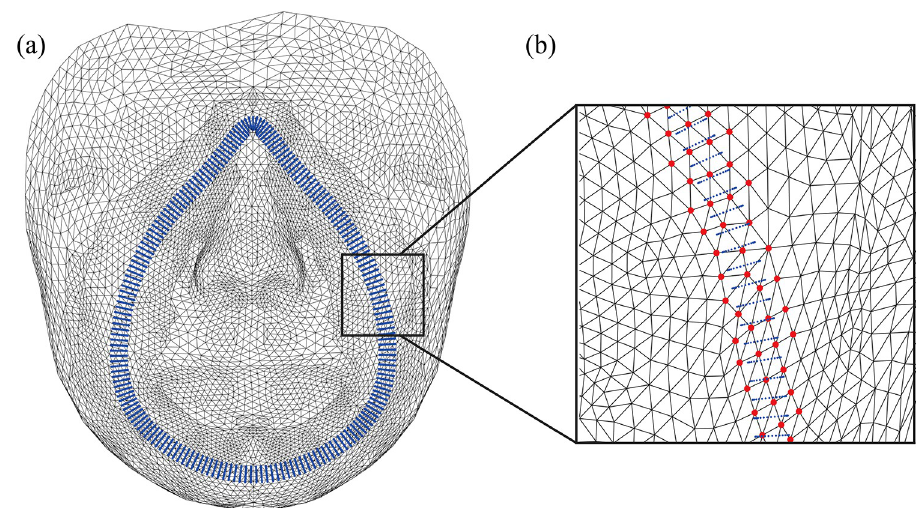
Fig 4. (a) Mask’s nodes (blue) and (b) mater nodes of the face (red), which consist of contact elements. https://doi.org/10.1371/journal.pone.0270092.g004 known matrix technique that reduces a matrix’s size by considering a few master nodes. The nodes of the face that contact the mask (interface nodes) are considered master nodes, and the others are defined as slave nodes. For the first step, the mask’s nodes (blue points in Fig 4A) are placed near the face. Second, the master nodes of the face (red dots in Fig 4B) are identified as the nearest element to the mask’s nodes. Third, the proposed procedure of the master node selection is applied for various design cases of the mask. Fig 5A illustrates the variation of the mask’s design created by adjusting the reference points of the mask along the X-axis direction. Finally, the complete set of master nodes (red dots in Fig 5B) concerning various mask designs are selected, then the remaining nodes (black points) are defined as the slave nodes. Using the identified master and slave nodes, the FE model of the face explained in Eq (9) is decomposed as